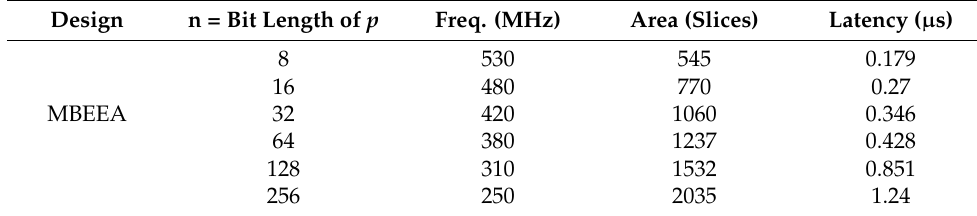
Table 4. FPGA implementation performance for the proposed MBEEA design in Virtex-7. Design